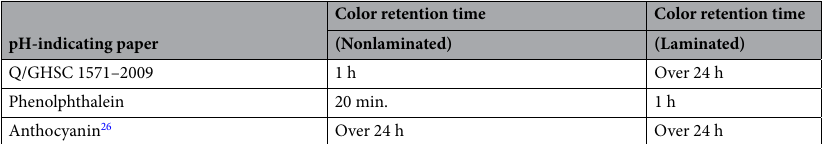
Color retention